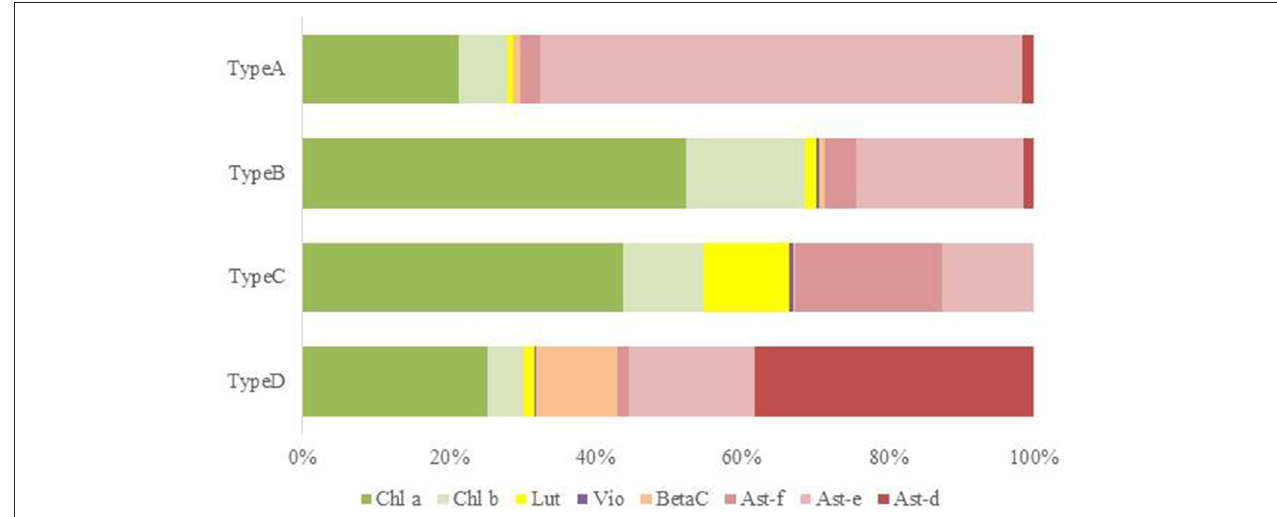
FIGURE 6 | Mean pigment composition of four types of red snow samples in Mt. Tateyama. Abbreviations: Chl a: chlorophyll a; Chl b: chlorophyll b; Lut: lutein; Vio: violaxanthin; BetaC: β -carotene; Ast-f: free-astaxanthin; Ast-e: astaxanthin-monoester; Ast-d: astaxanthin-diesters.